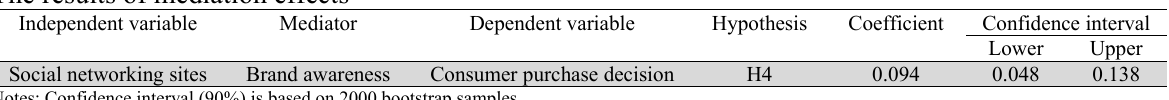
The results of mediation effects Independent variable Mediator Dependent variable Hypothesis Coefficient Confidence